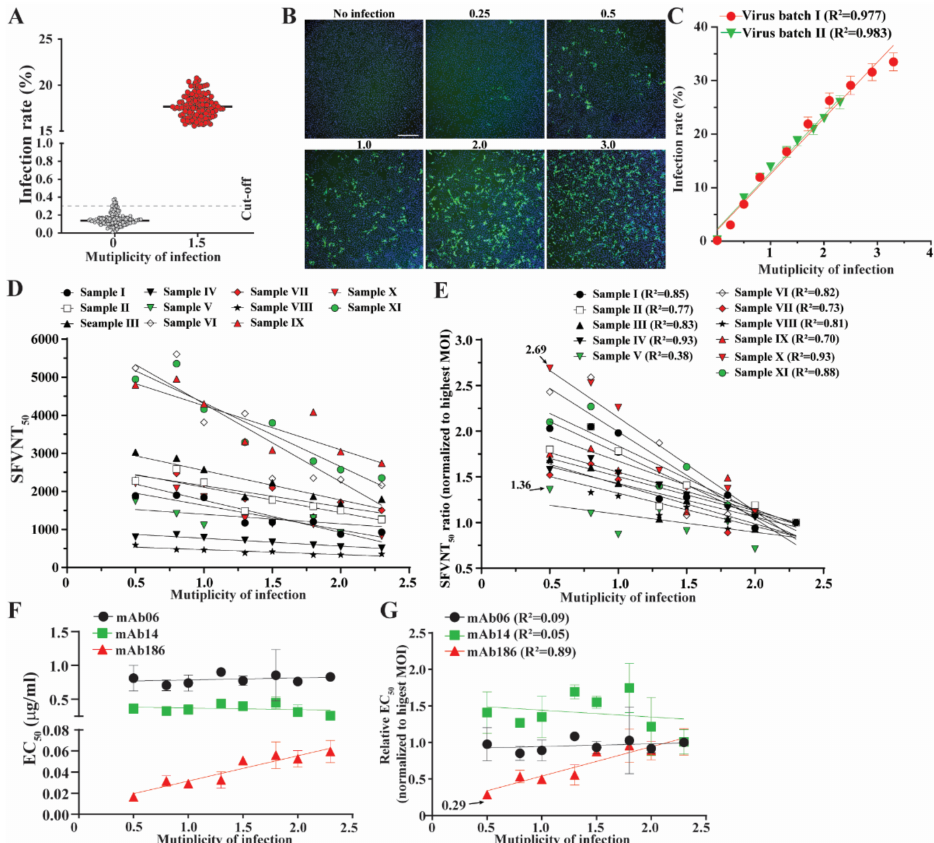
Figure 2. Optimization of MOIs for the SFVNT. ( A ) Background of autofluorescence from uninfected cells. A total of 120 wells of uninfected or infected (MOI of 1.5) A549-hACE2 cells were scanned by high-content imaging. Infection rates were calculated. The dotted line indicates the mean of the infection rate plus two times the standard deviation from uninfected wells. ( B ) Representative fluorescence images of A549-hACE2 cells infected with various amounts of input viruses. Numbers above each panel indicate the multiplicity of infection (MOI). ( C ) Correlation between MOIs and the infection rate. Two virus batches were tested. Pearson’s correlation coefficients are shown. p values (two-tailed) < 0.0001. ( D ) The correlation between the MOI and the SFVNT 50 values. Eleven neutralization-positive samples were evaluated by the SFVT with various amounts of input viruses (MOI from 0.5 to 2.3). ( E ) The correlation between the MOI and normalized SFVNT 50 values. For each sample, the SFNVT 50 values were normalized to that obtained from an MOI of 2.3. ( F ) The analysis of MOI and normalized SFVNT 50 values of three monoclonal antibodies. SFNVT 50